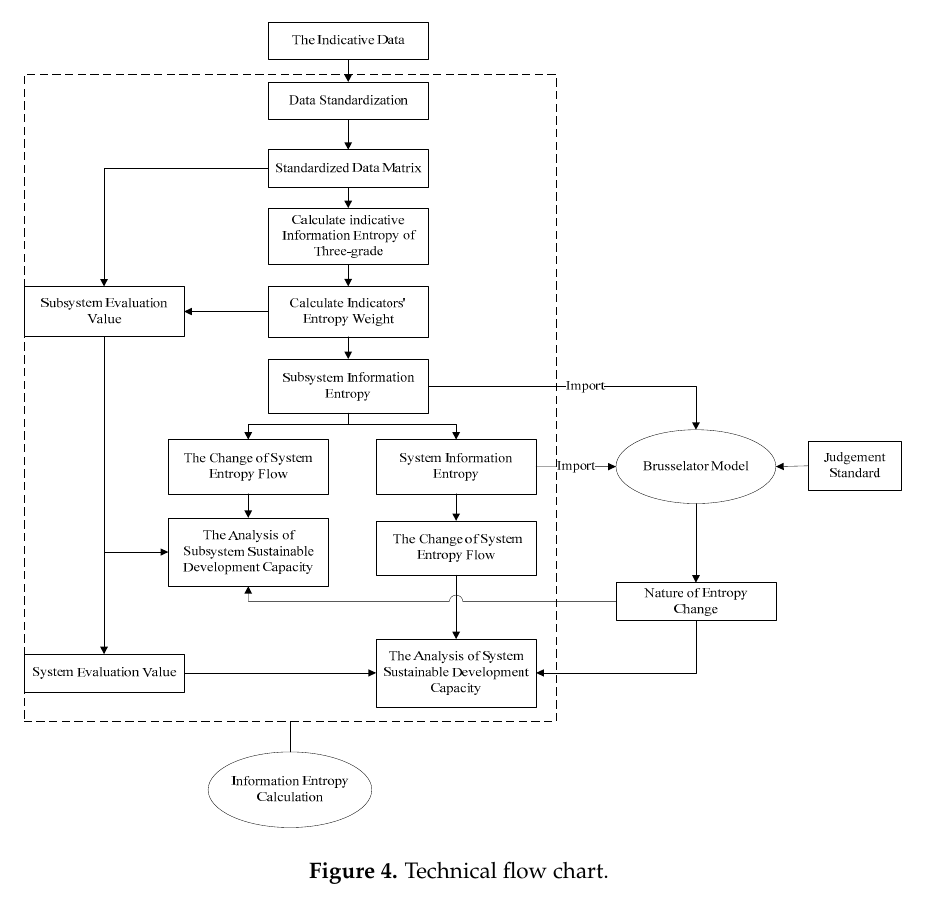
Figure 4. Technical flow chart.